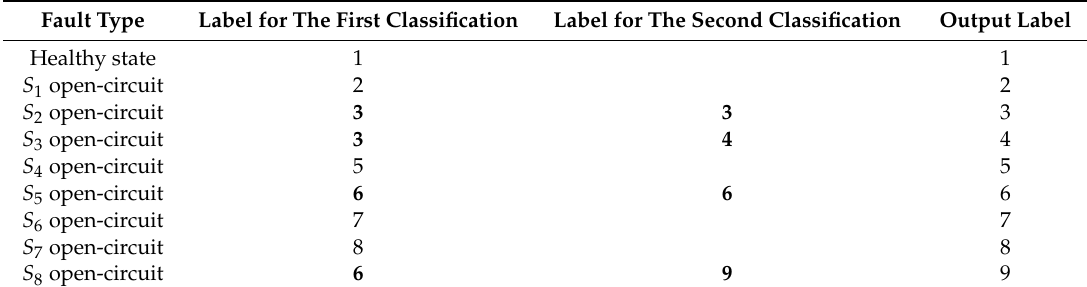
Table 3. Fault labels in di ff erent level classification